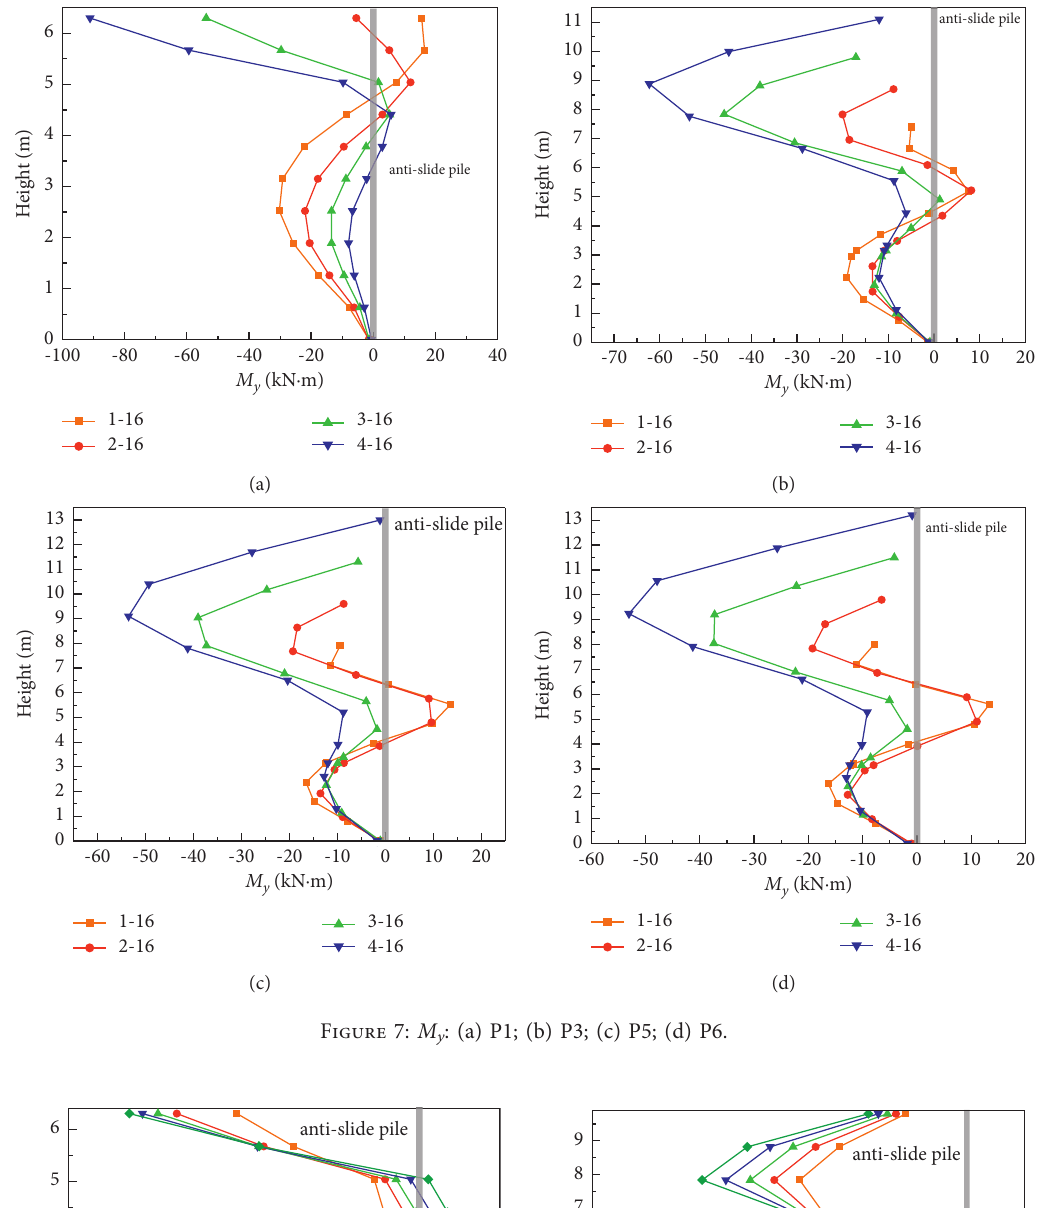
Figure 7: M y : (a) P1; (b) P3; (c) P5; (d) P6.